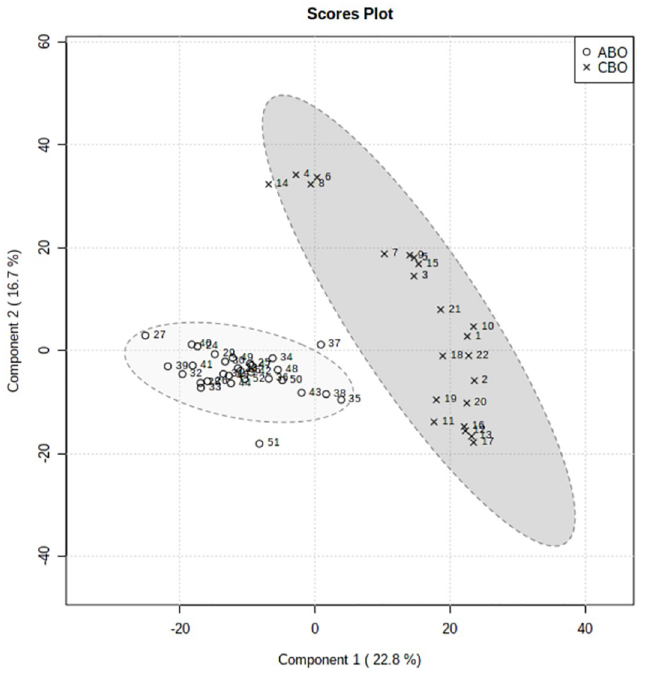
Fig 5. PLS-DA scores plot between the Comp1 and Comp2.